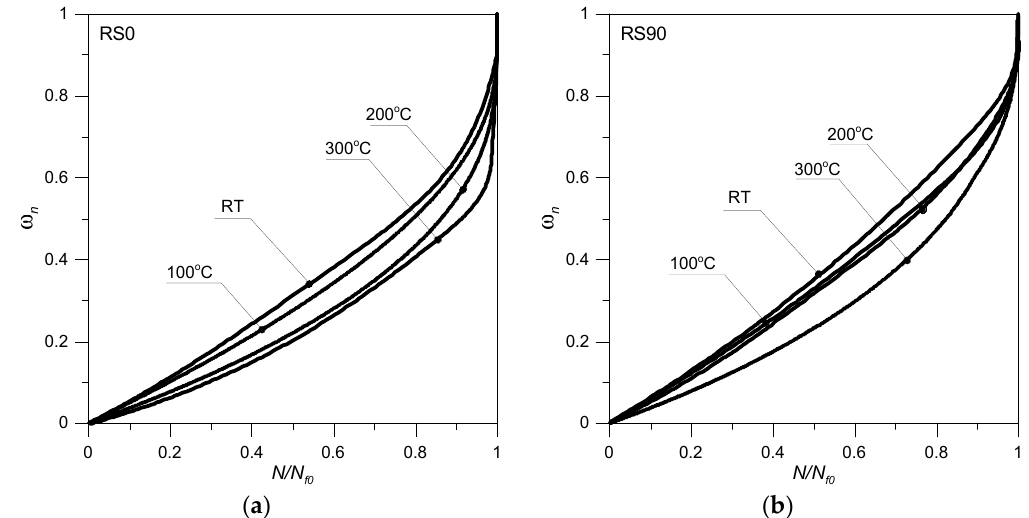
Figure 11. Evolution of damage state variable normalized with respect to cycles until crack initiation at the analyzed temperature for load path: ( a ) RSO; ( b ) RS90.